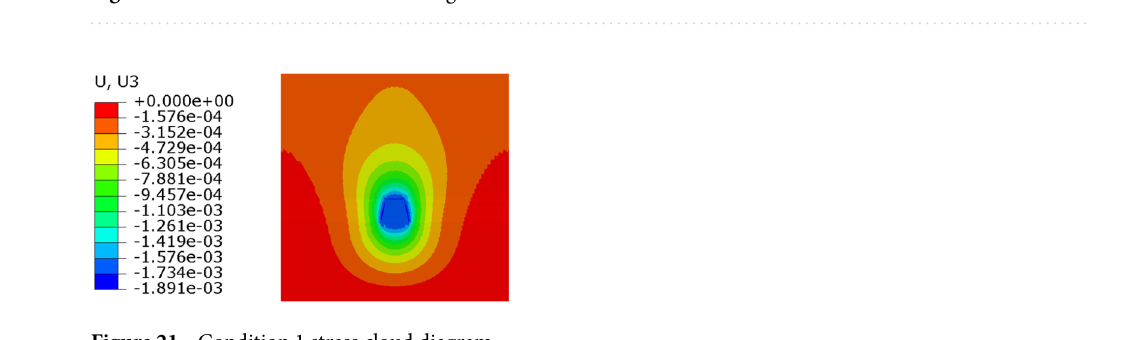
Figure 20. Condition 1 stress cloud diagram.